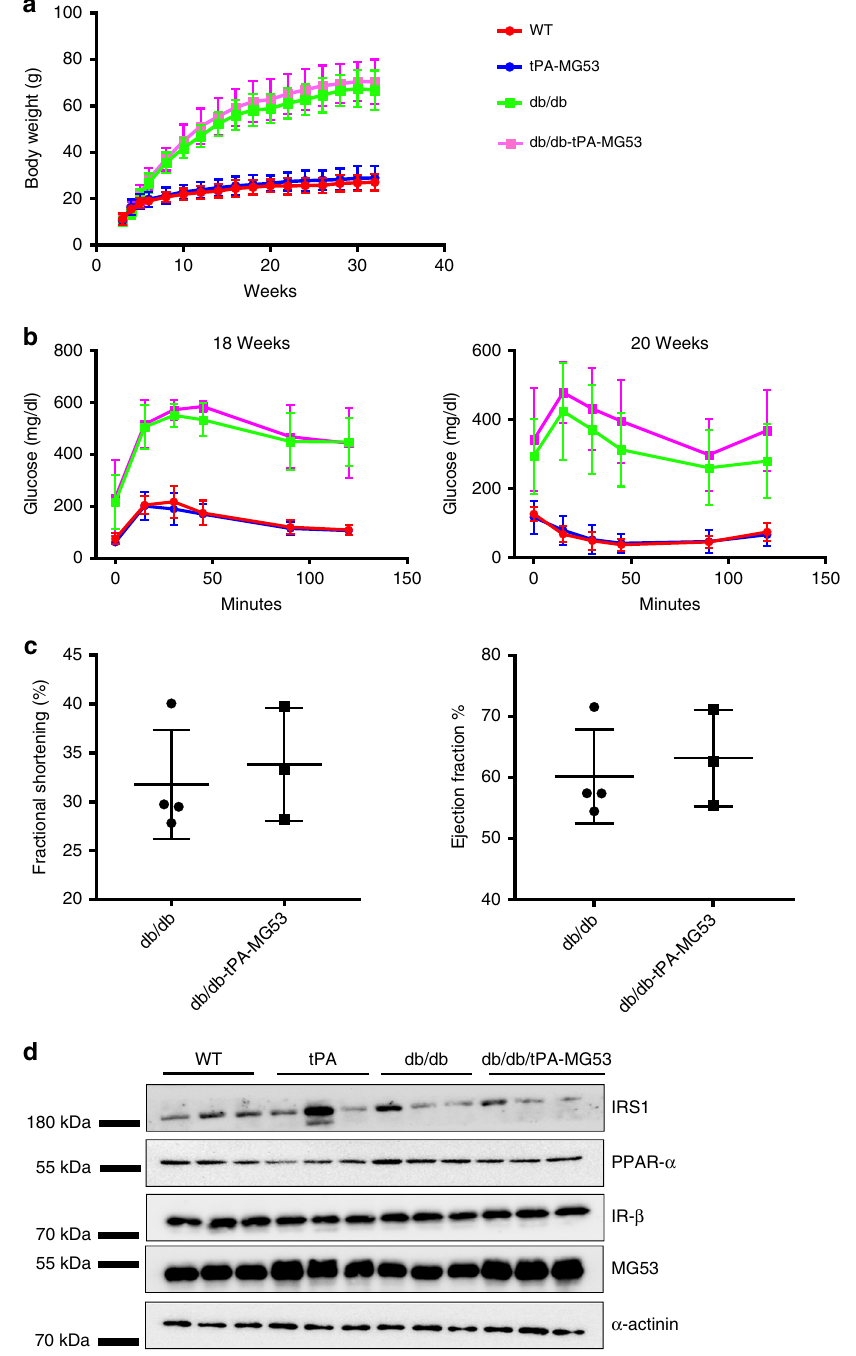
Fig. 8 Cross of tPA-MG53 mice with db/db mice did not alter the diabetic phenotype. a Growth patterns of WT and tPA-MG53 littermates; and db/db and db/db -tPA-MG53 littermates were followed during the period of 3 – 32 weeks, under normal diet conditions. b GTT tests were conducted with the four groups of mice at 18 weeks of age (left). ITT tests were conducted at 20 weeks of age. No signi fi cant differences were observed among the WT and tPA- MG53, and db/db and db/db -tPA-MG53 groups, respectively. n = 6 for WT, n = 5 for tPA-MG53, n = 6 for db/db , and n = 5 for db/db- tPA-MG53. c Echocardiogram shows similar ejection fraction and fractional shortening between db/db -tPA-MG53 and db/db littermates. d Western blot of soleus muscle derived from the four groups of mice. Expression levels of IRS-1, IR- β , and PPAR α were probed with the respective antibodies. α -actinin serves as loading control. Error bar represents the standard